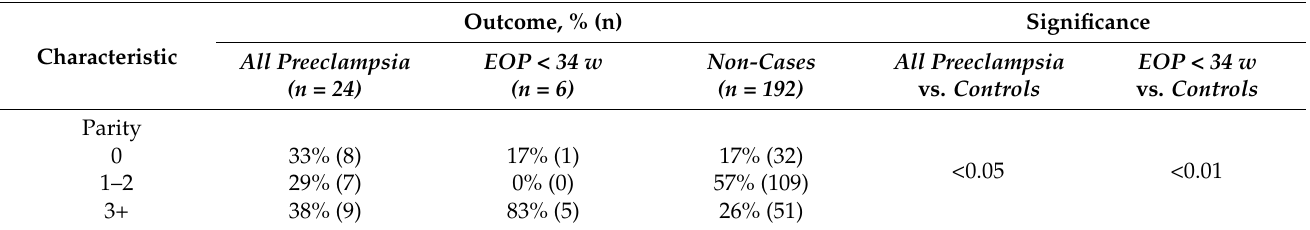
Table 8. Relationships of maternal characteristics (parity) and preeclampsia during current